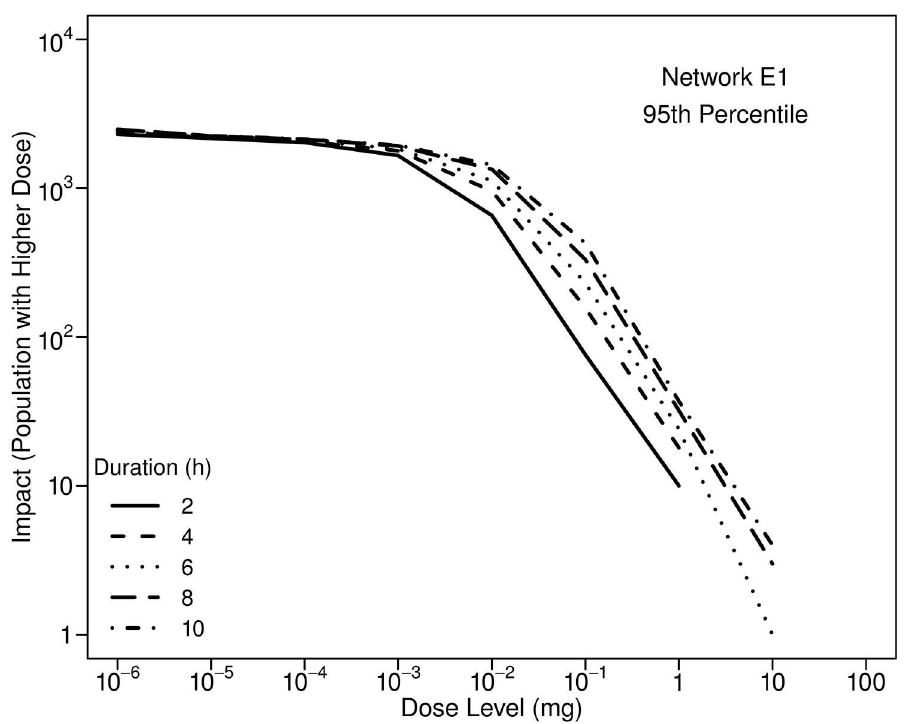
Fig 10. Influence of the daily duration of humidifier use on 95th percentile impacts. Results are for Network E1, an injectionat 0:00 with a mass equal to 10 kg, and a fill time for all humidifiers of 22:00. Ultrasonichumidifiers are assumed to be used by 20% of the